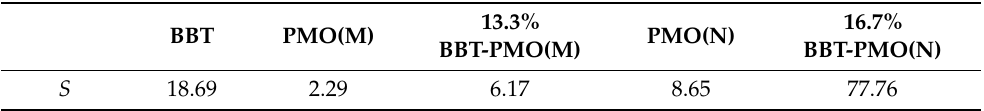
Table 2. Specific surface area (S, unit: m 2 /g) of 13.3% BBT-PMO(M), PMO (M), BBT, 16.7% BBT-